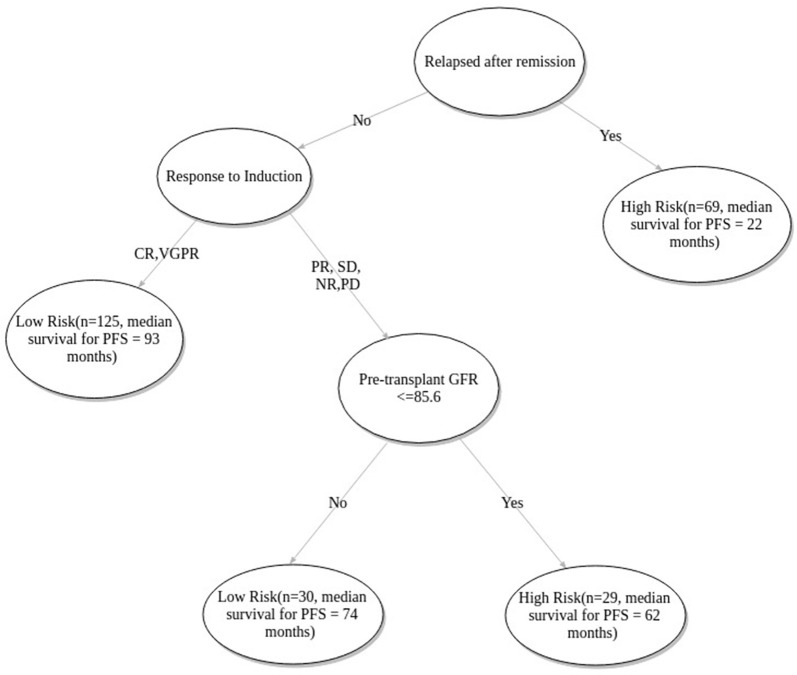
Fast-and-frugal tree based staging scheme for patients undergoing ASCT. CR, Complete Response; VGPR, Very Good Partial Response; PR, Partial Response; NR, No Response; SD, Stable Disease; PD, Progressive disease.